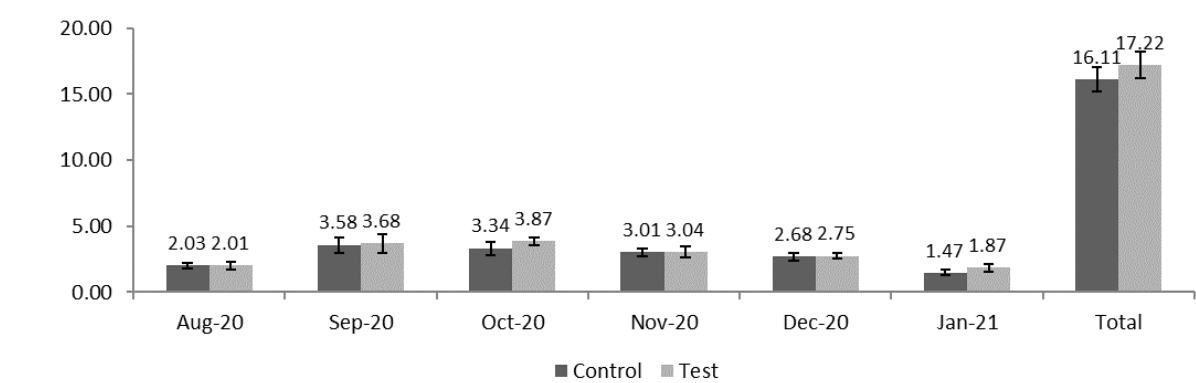
Figure 3. Total yield (kg/m 2 ) per experimental piece per month.